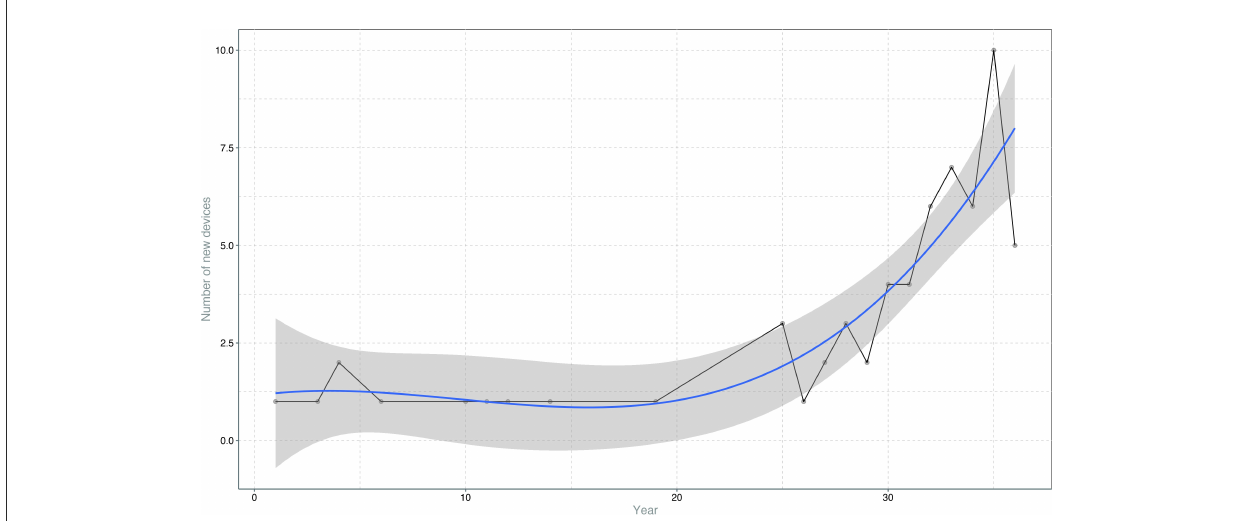
FIGURE2 Distribution of the number of new systems described in publications every year; black line is the empirical value, the blue line is the predicted value and the grey area represents the 95% confidence interval for the estimated number of studies. The prediction model uses a cubic regression that was chosen due to the lowest AIC and BIC scores (as described by Burnham and Anderson, 2004) when compared to other models of orders 1–5.